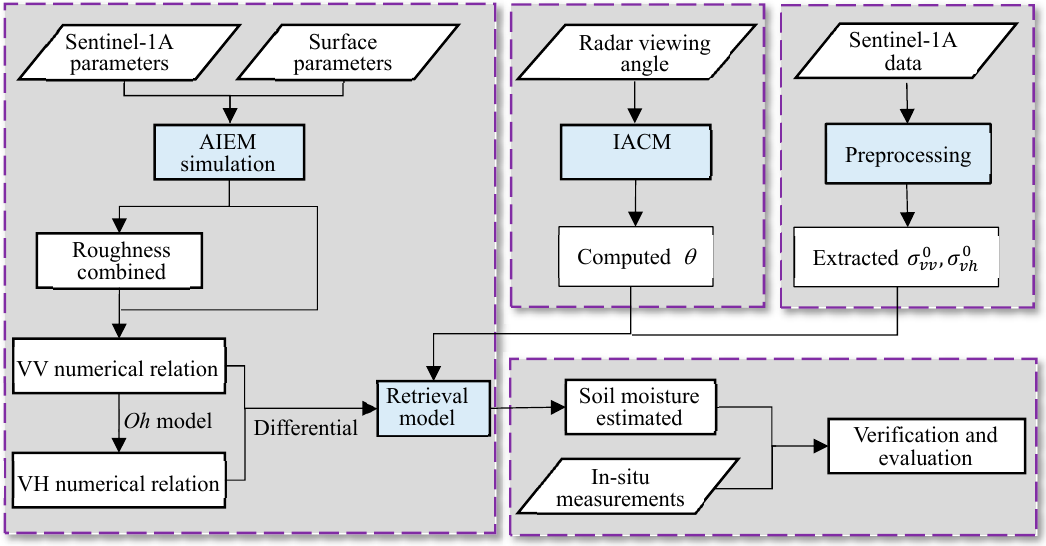
Figure 4. Flowchart for the soil moisture retrieval using the improved approach. θ is the local incidence angle at the scatterer. σ 0 vv , σ 0 are the backscattering coefficients from VV polarization and VH polarization, respectively.